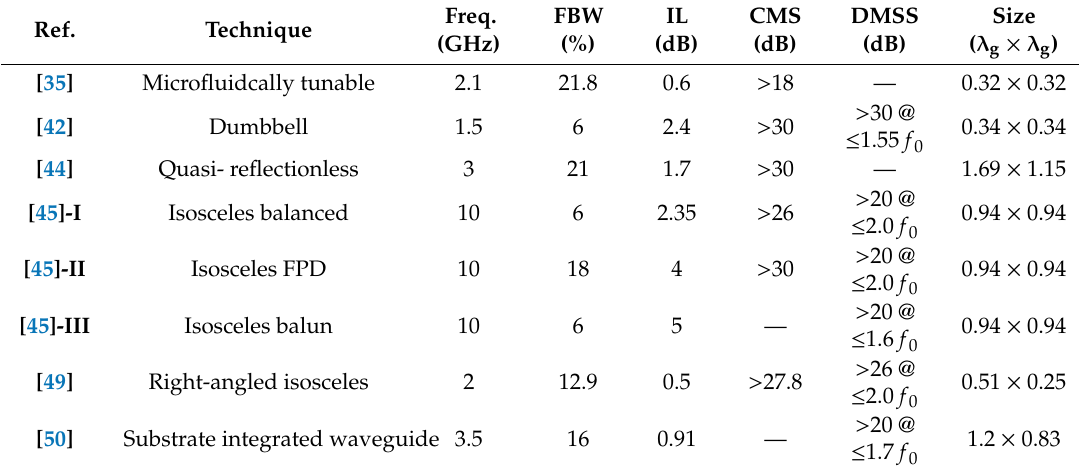
Table 1. Performance comparisons for some recent single-band di ff erential microstrip BPFs.